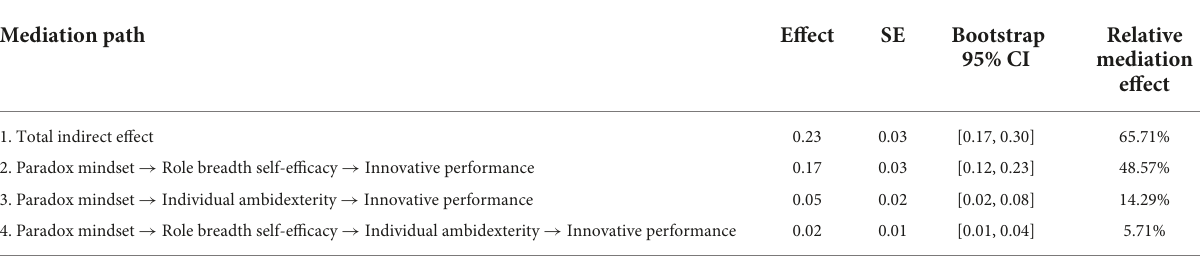
TABLE 5 The mediation effect